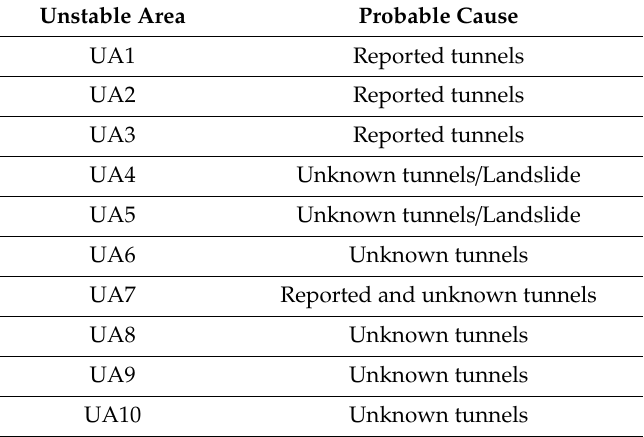
Table 2. List of unstable areas (UAs) and probable cause of the observed SAR displacement